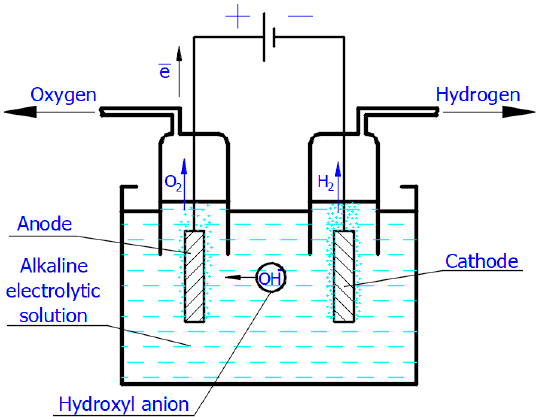
Figure 2. Scheme of the simplest alkaline electrolytic cell illustrating production of H 2 and O 2 according to Equations (2) and (4). The scheme shows only hydroxyl anions participating in the charge transport.